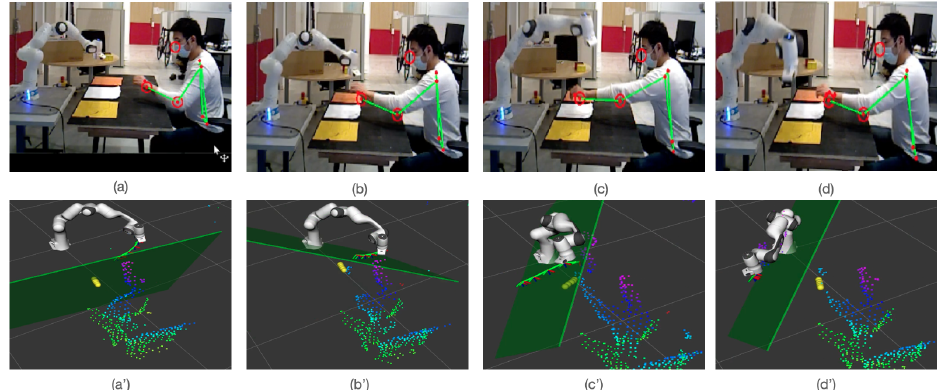
Figure 9. The qualitative visualization of collaborative environment between cobot and human, ( a ) shows the distance between cobot and hand, which is much larger than safety distance (20 cm), ( b ) shows the behavior of the cobot when the human hand is intentionally placed for possible collision, the cobot deviates from its initial trajectory to avoid the collision, ( c , d ) show that the cobot achieves its goal without stopping or hurting the human while keeping a safe distance. The sub-figures from ( a’ – d’ ) show the corresponding visualization of the same data in RVIZ.